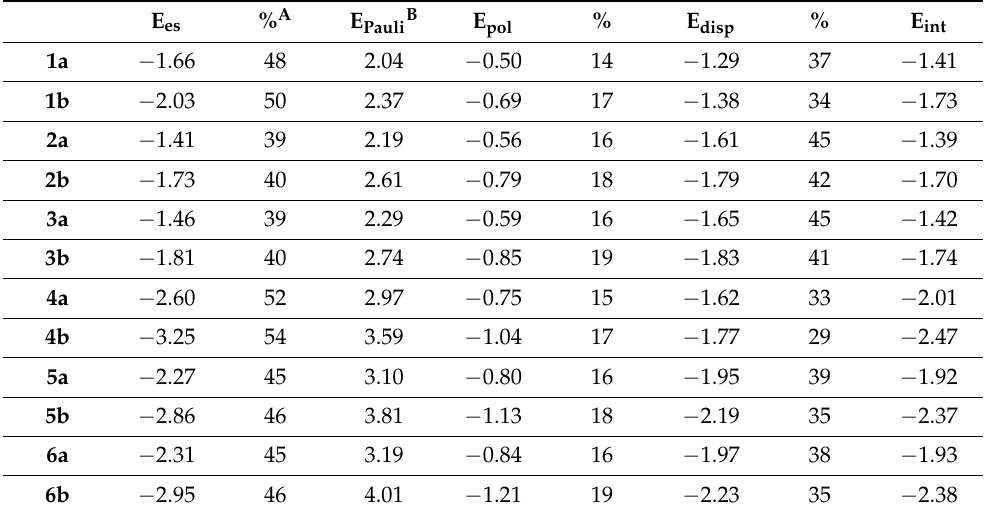
Table 4. LMOEDA/MP2/aug-cc-pVDZ decomposition of the interaction energy in vacuum of complexes into electrostatic (E es ), Pauli repulsion (E Pauli ), polarization (E pol ) and dispersion (E disp ) components. All quantities in kcal/mol.